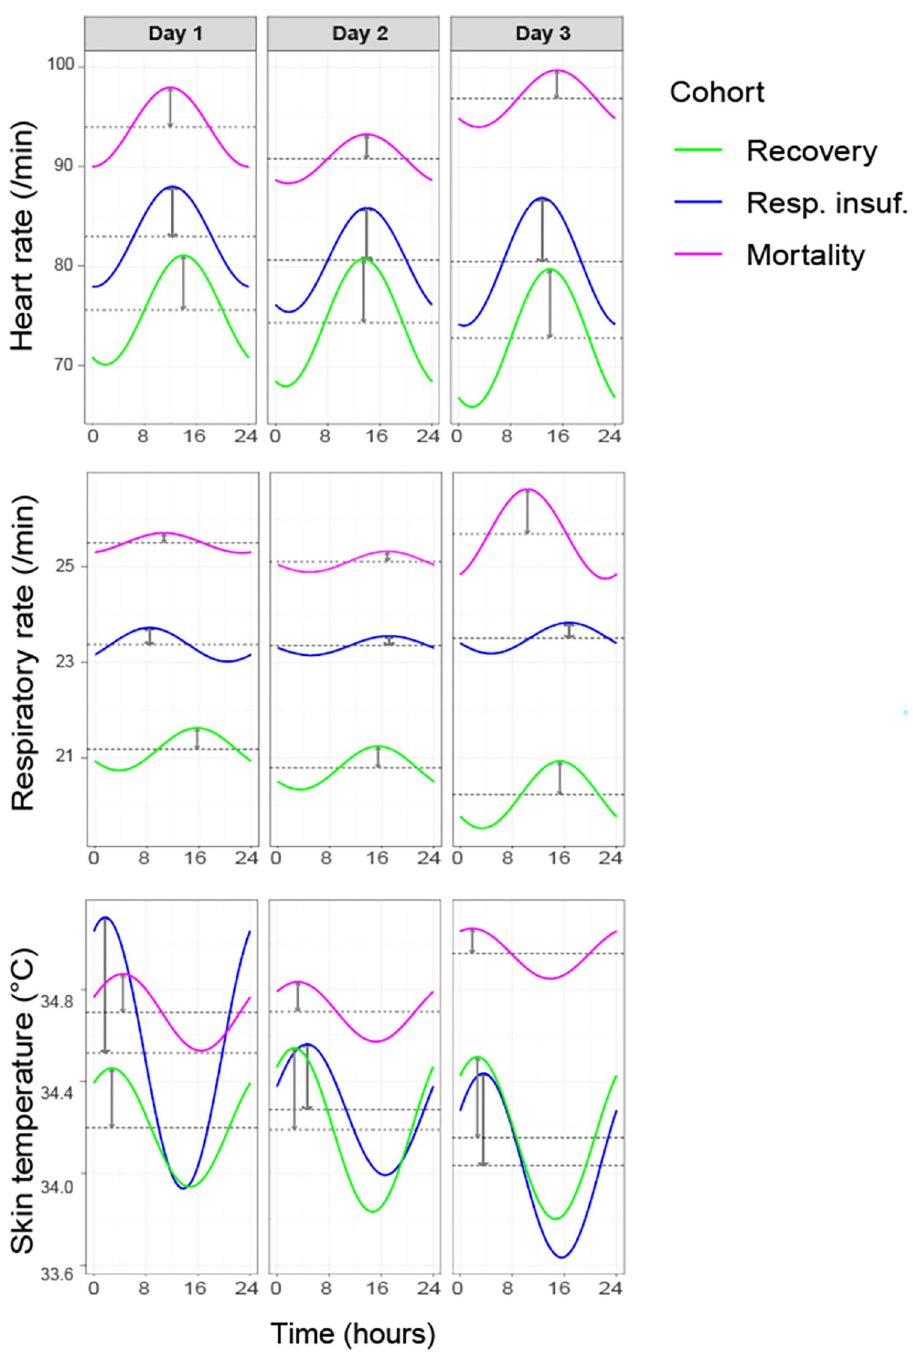
Fig 3. Progression of cosinor characteristics over the course of three days for heart rate, respiratory rate and skin temperature, stratified by cohort.